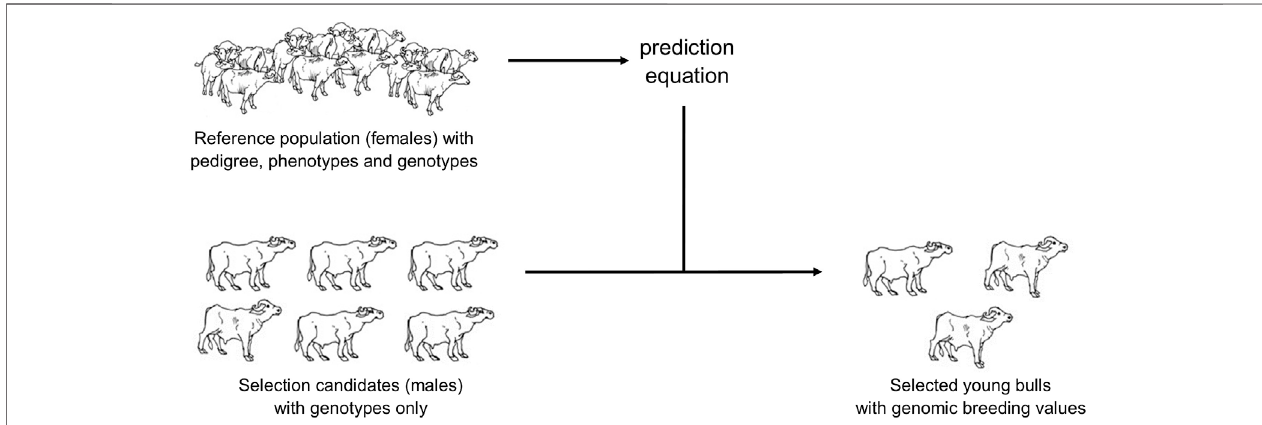
FIGURE 2 | Genomic selection in Philippine dairy